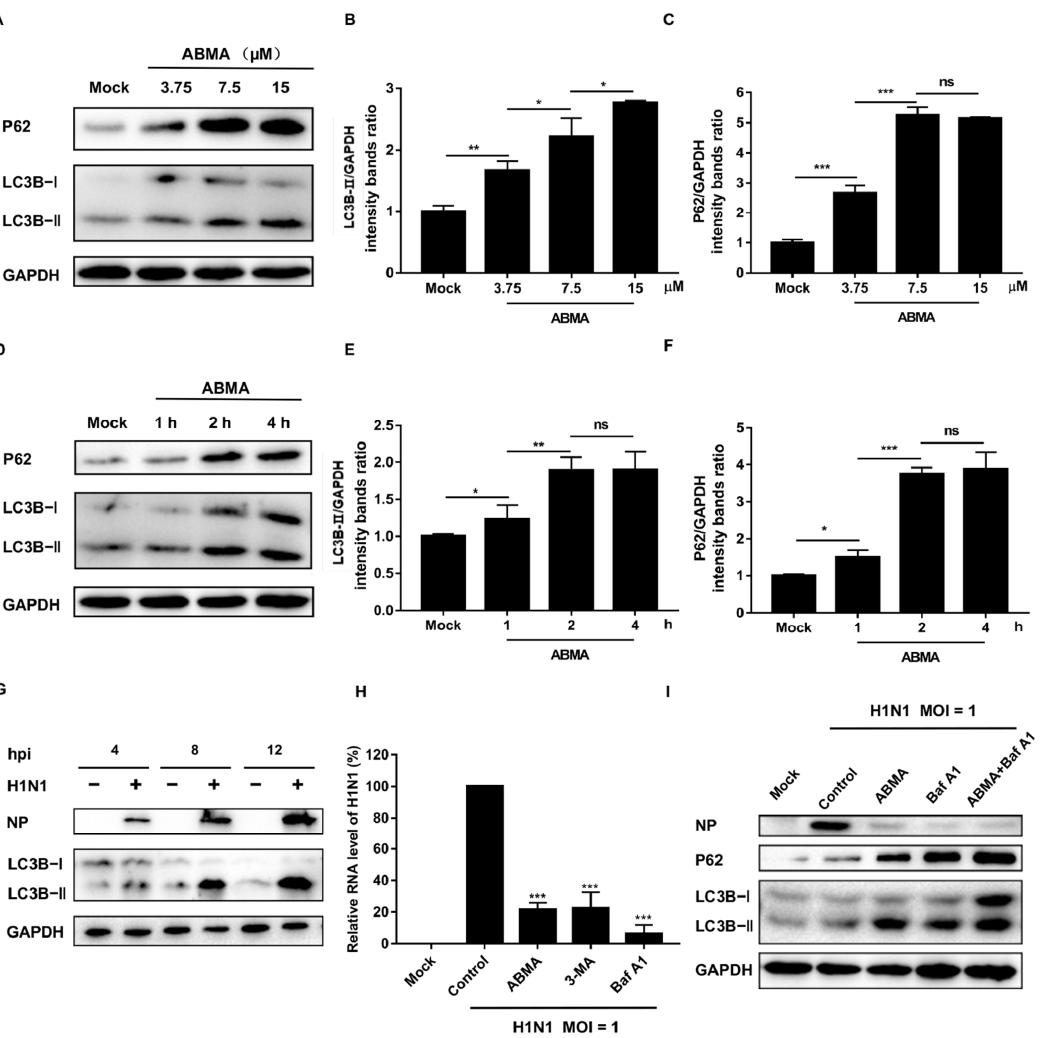
Figure 5. Inhibitory effects of ABMA on the autophagic flux and subsequent impacts on